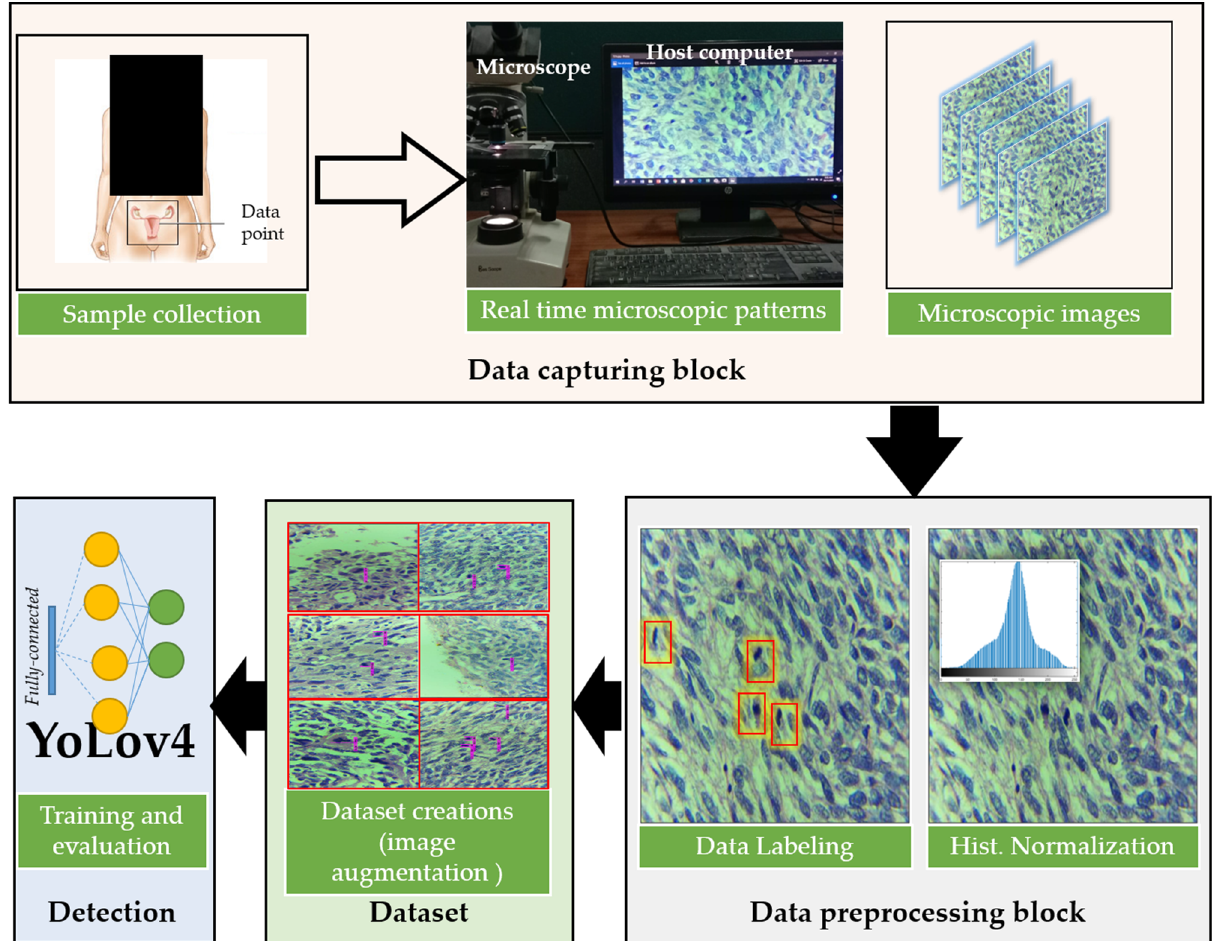
Figure 2. The overall framework of the proposed method. (The microscopic image of the uterine leiomyosarcoma (ULMS) case with red highlighted areas showing the mitosis region.)